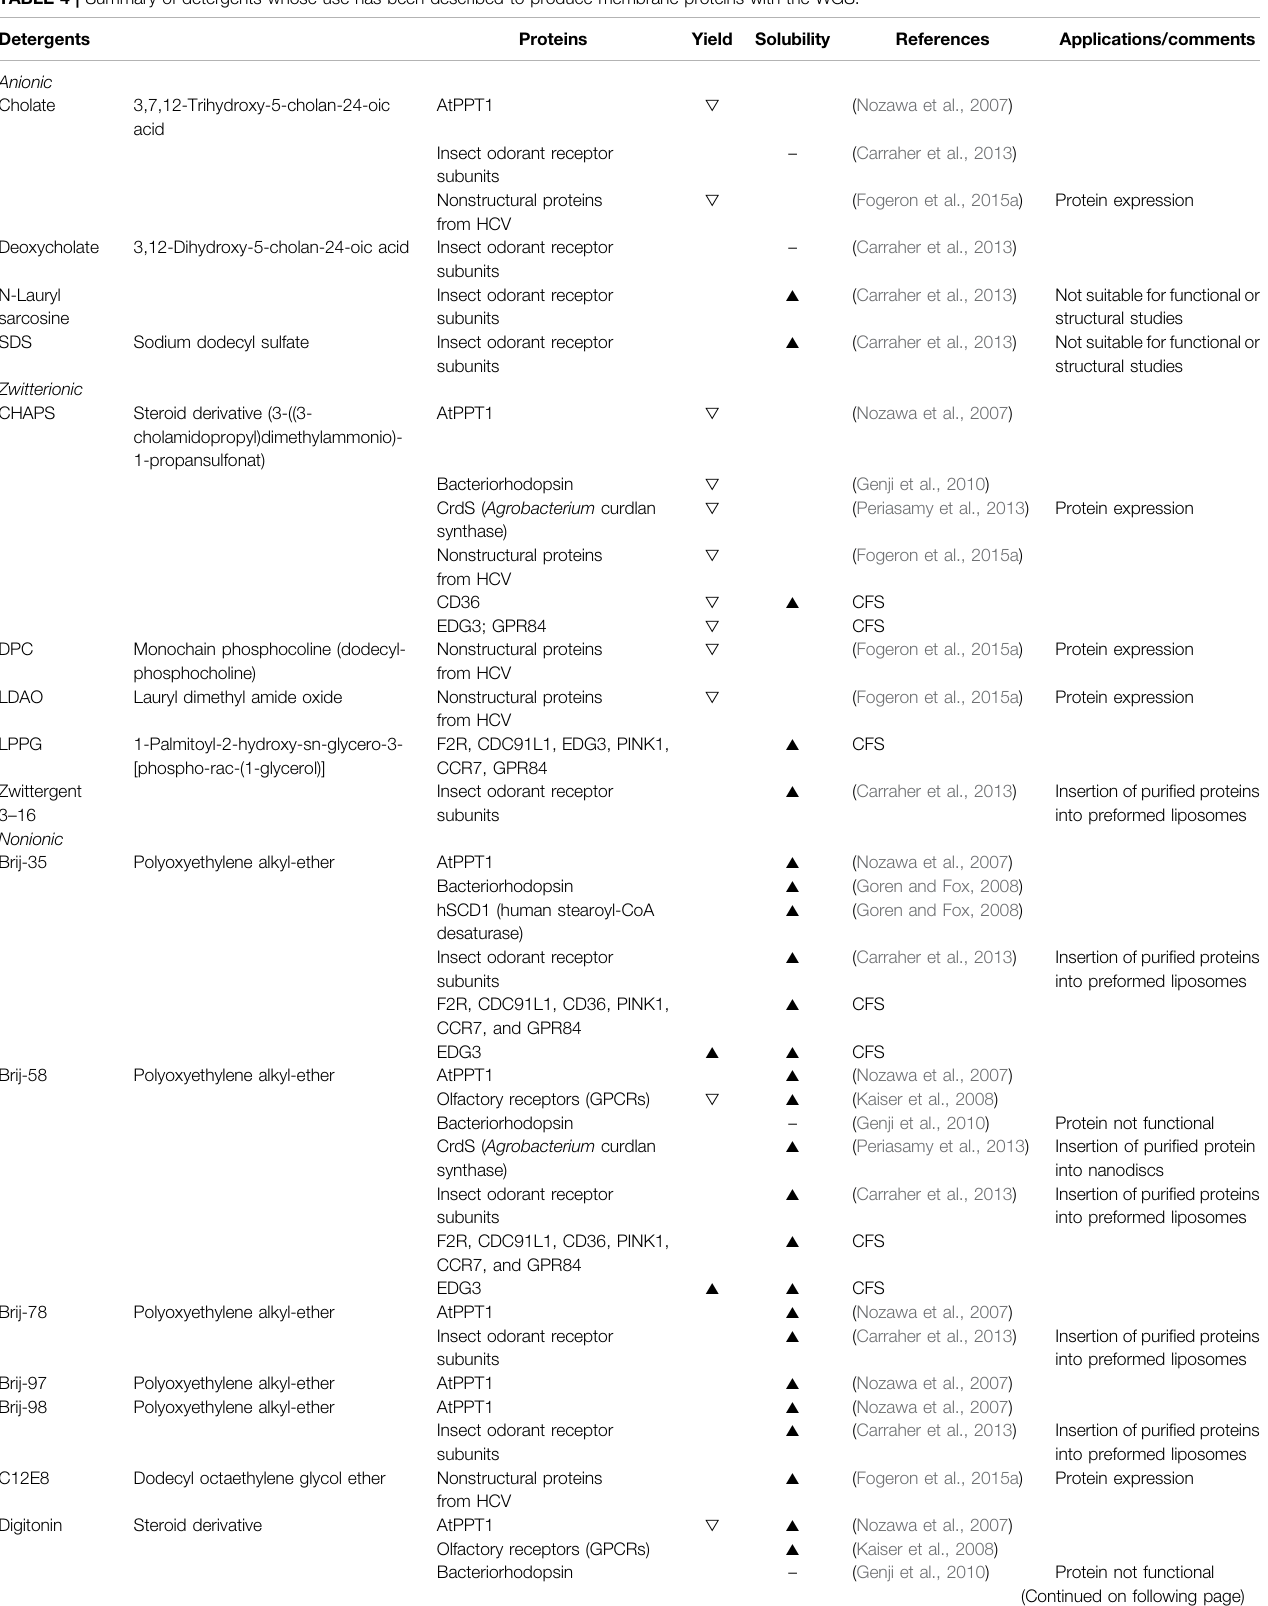
TABLE 4 | Summary of detergents whose use has been described to produce membrane proteins with the